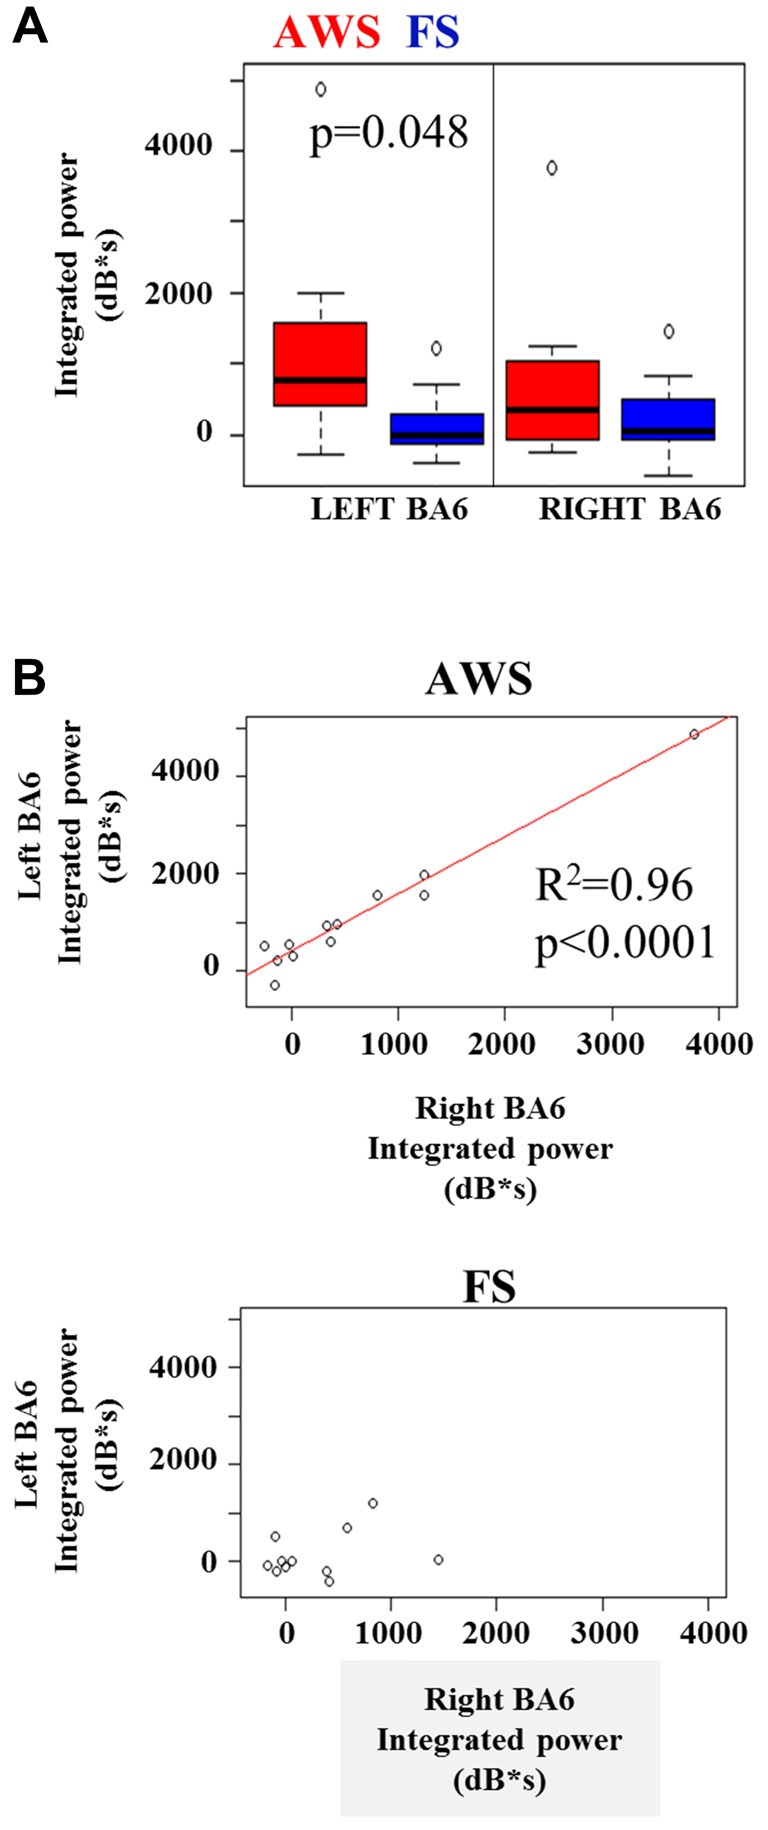
(A) Integrated beta ERS power in the left and right mouth motor cortex (BA6) preceding stimulus onset. (B) Significant linear relationship between the integrated beta ERS in the left and right BA6 of AWS (top). No significance found in FS (B, bottom).